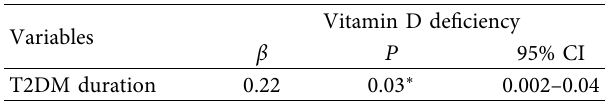
Table 5: Linear regression analyses to identify predictors of vitamin D status among